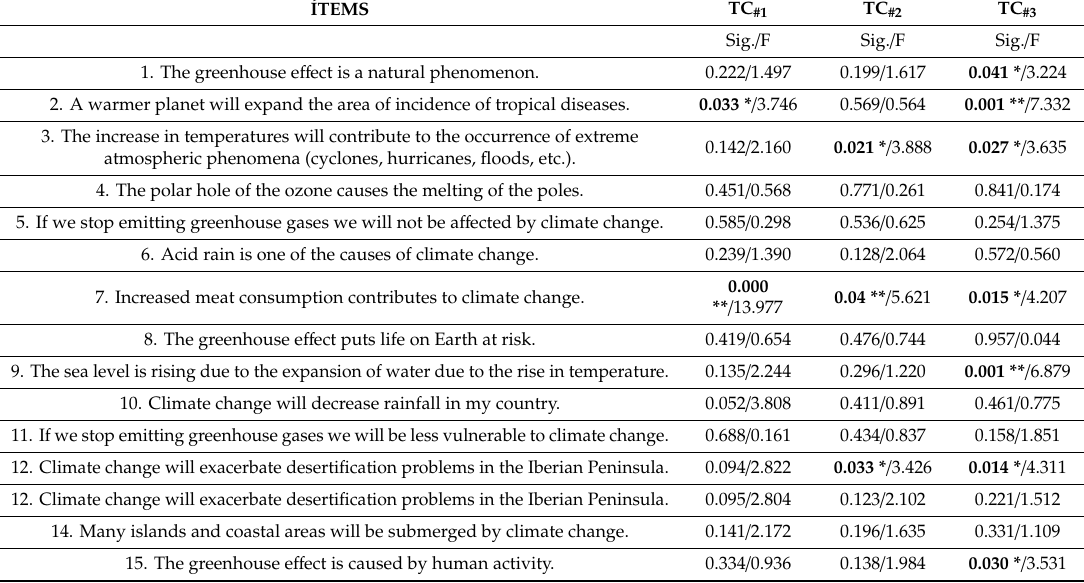
Table 16. Have you participated in any specific training activity related to the